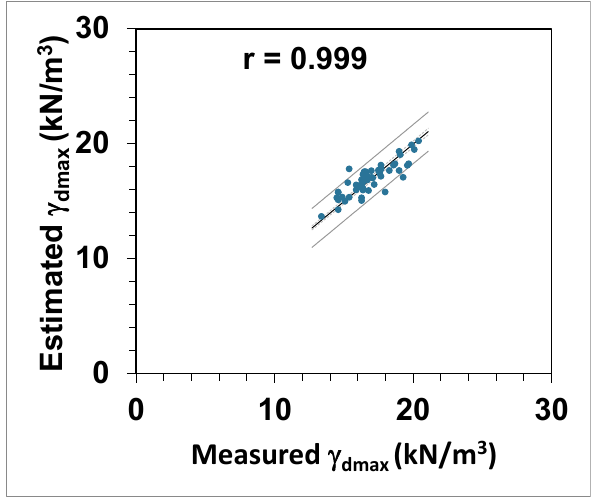
Figure 2. Correlation between measured and estimated dmax using data from [19].